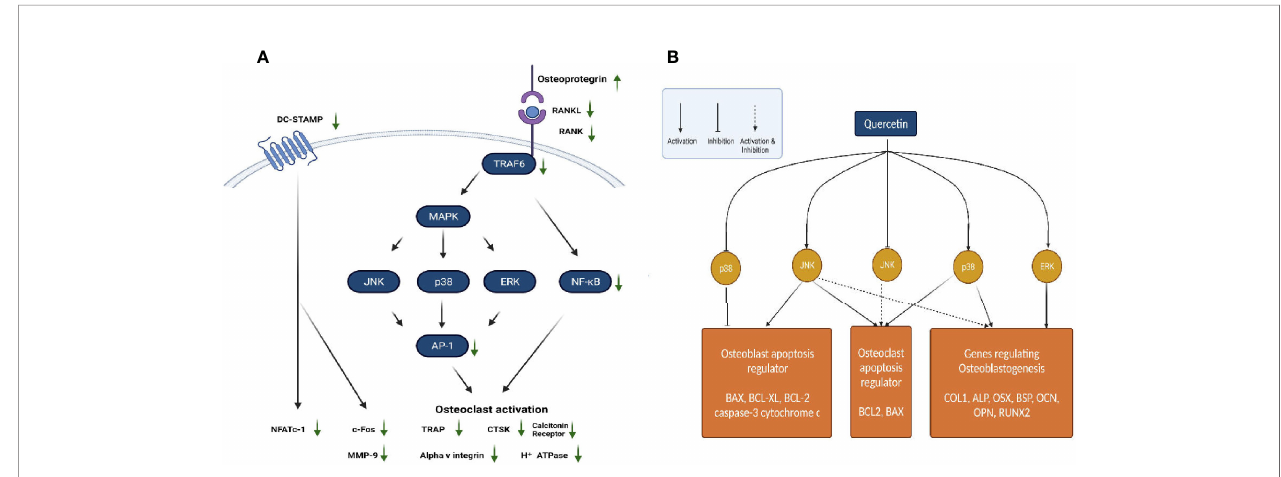
FIGURE 1 | (A) Regulation of RANK/RANKL/OPG system by quercetin. (B) Actions of quercetin on JNK, ERK and p38 MAPK